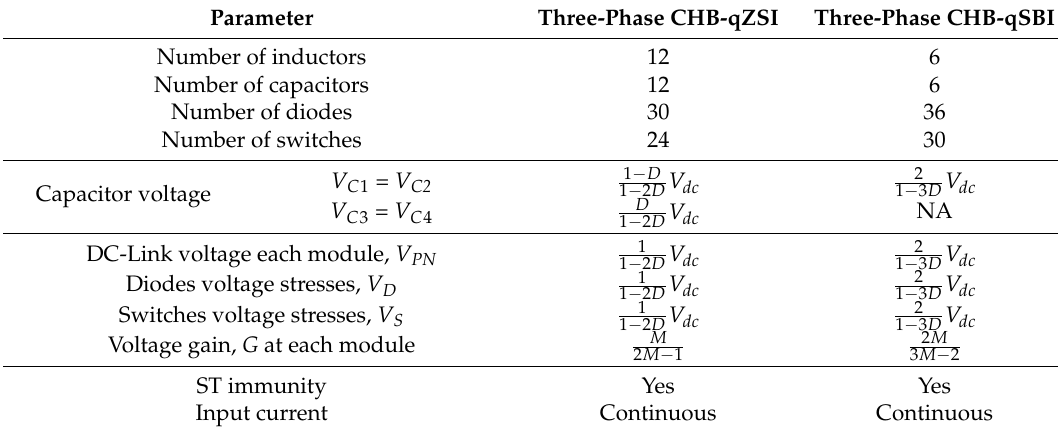
Table 2. Comparison between CHB-qSBI and